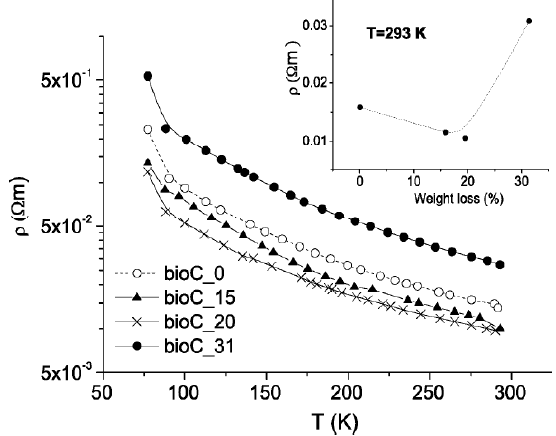
Fig. 5. Temperature dependence of the electrical resistivity of as processed and activated biocarbons with different weight losses. Insert: Electrical resis- tivity versus weight loss after activation. The resis- tivity was measured without regard for the